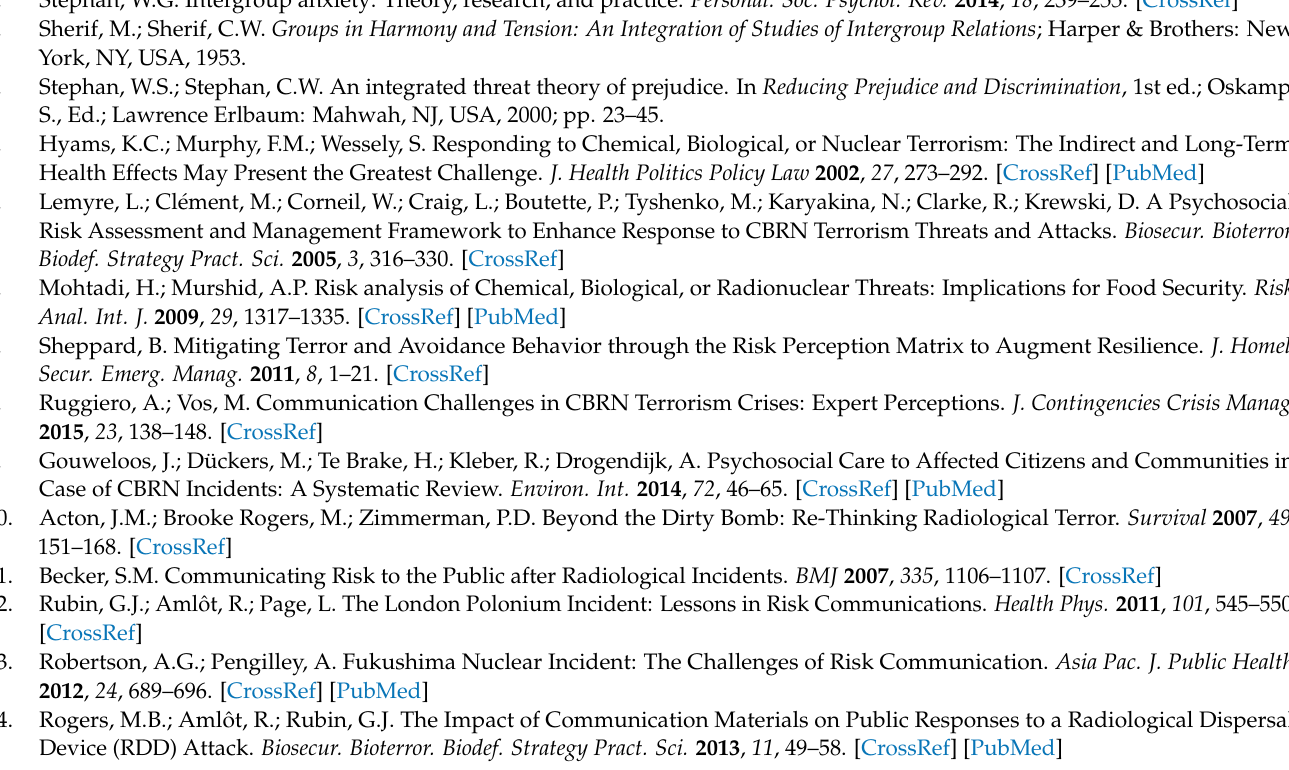
Figure A3. Screenshot of the mock social media rumor (fake news) post for the chemical scenario. The text on the rumors/fake news post (Figure A3) reads: “In short–rush to the hos- pitals to get checked! They aren’t telling you the truth about the terror attack on the train. On site there are way more casualties and dead than reported on the news. Chlorine is a dangerous gas that chokes people and it is being used as a chemical weapon in Syria and Iraq”.